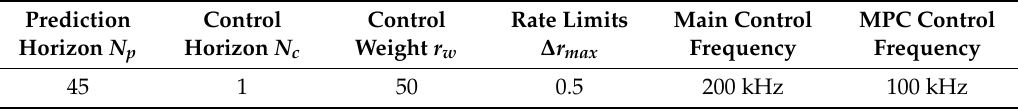
Table 2. MPC voltage-mode reference governor